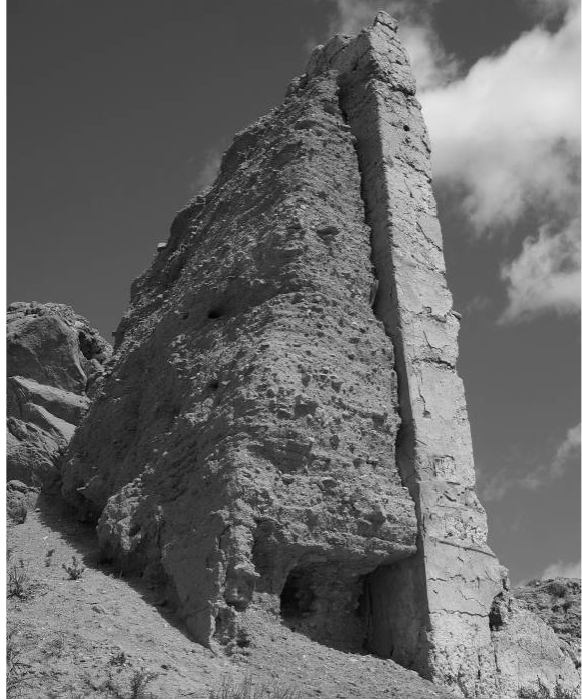
Figure 7. Tower B. (TC) attached to the outer face of (ME1).